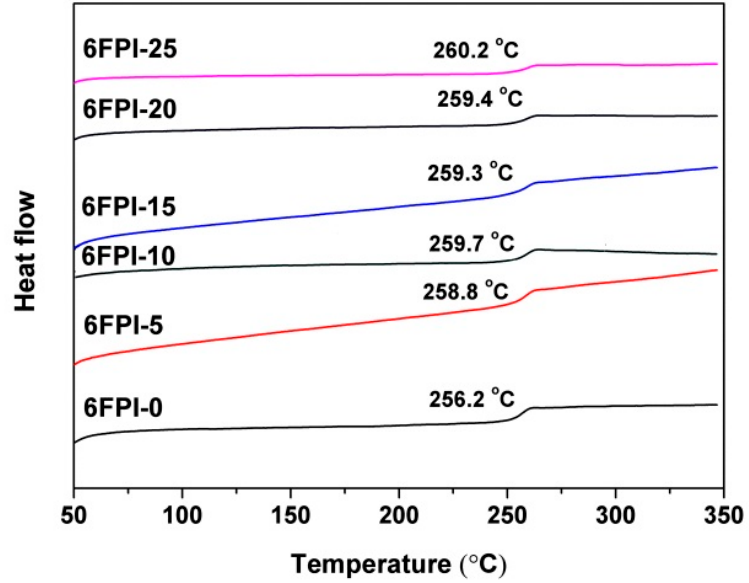
Figure 12. DSC curves 6FPI/POSS composite films under nitrogen flow. Although the incorporation of TSP-POSS additives into the PI matrix did not bring negative effects on the T g values of the PI composite films, they deteriorated the high- temperature dimensional stability of the polymers, as could be evidenced by the